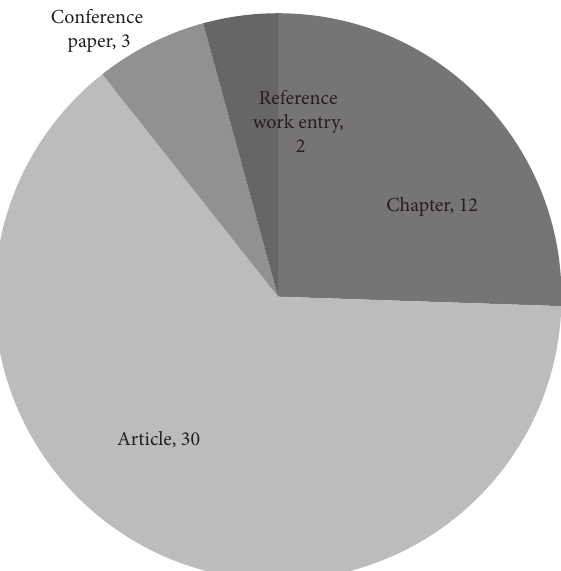
Figure 12: Publication type with their number of